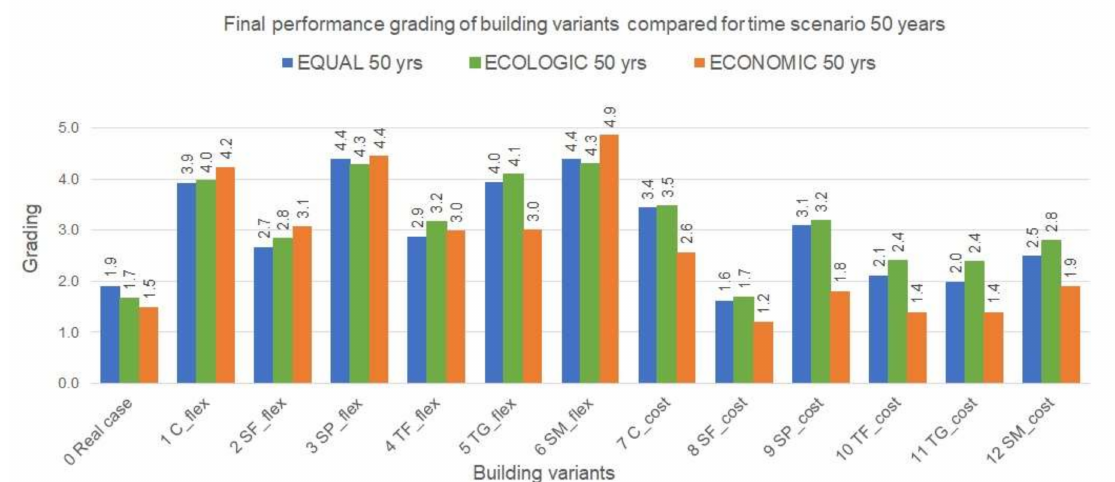
Figure 7. Final performance grading and comparison of the examined building variants for the time scenario 50 years and the weighting scenarios (equal, ecologic and